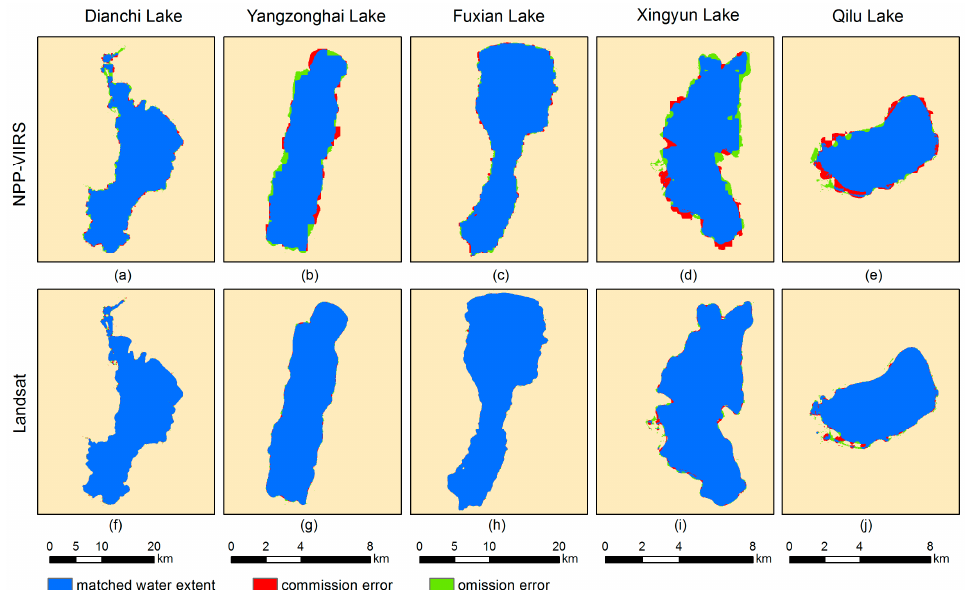
Figure 7. Validation results of subpixel mapping of: ( a ) Dianchi Lake from the NPP–VIIRS; ( b ) Yangzonghai Lake from the NPP–VIIRS; ( c ) Fuxian Lake from the NPP–VIIRS; ( d ) Xingyun Lake from the NPP–VIIRS; ( e ) Qilu Lake from the NPP–VIIRS; ( f ) Dianchi Lake from the Landsat; ( g ) Yangzonghai Lake from the Landsat; ( h ) Fuxian Lake from the Landsat; ( i ) Xingyun Lake from the Landsat; and ( j ) Qilu Lake from the Landsat.